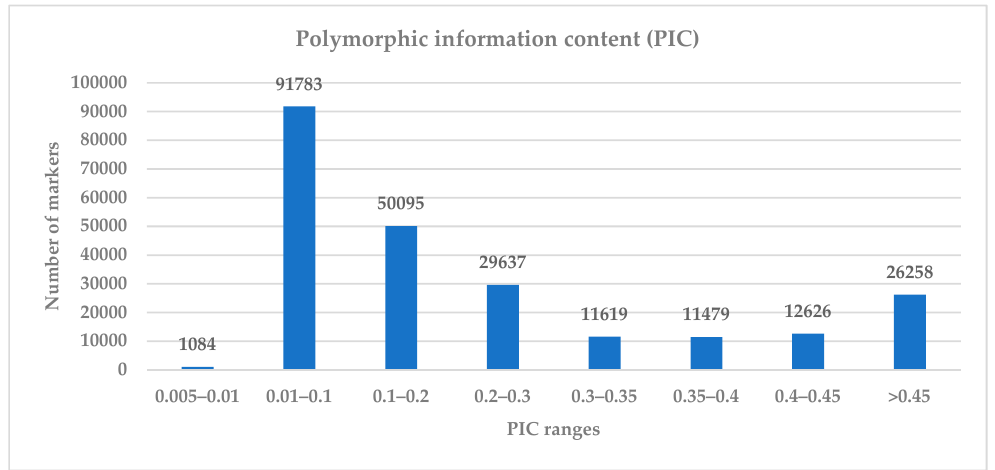
Figure 2. Frequency of single nucleotide polymorphism (SNP) marker by polymorphic information content (PIC) values.